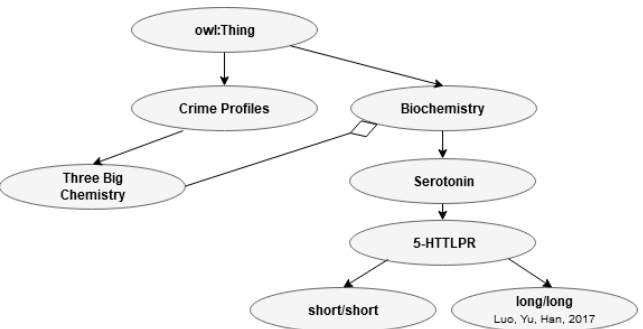
Figure 10. Relationship between biochemistry (B) and biochemistry